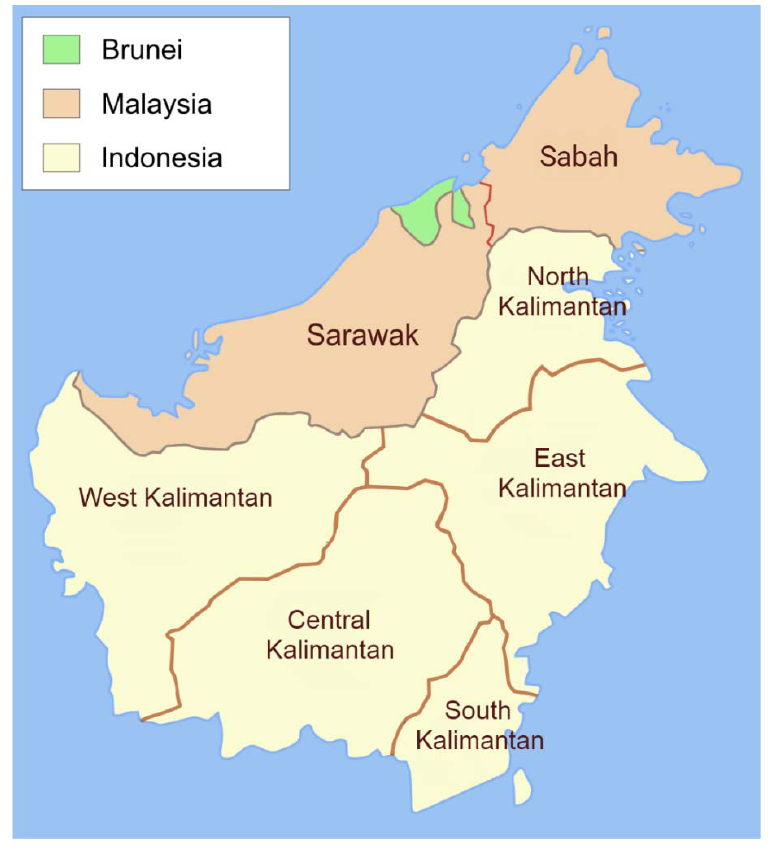
Figure 1. The island of Borneo. Source: Ranking Update, CC BY ‐ SA 3.0. Wild, untamed, unexplored, dangerous, mysterious, and exotic are the projected im ‐